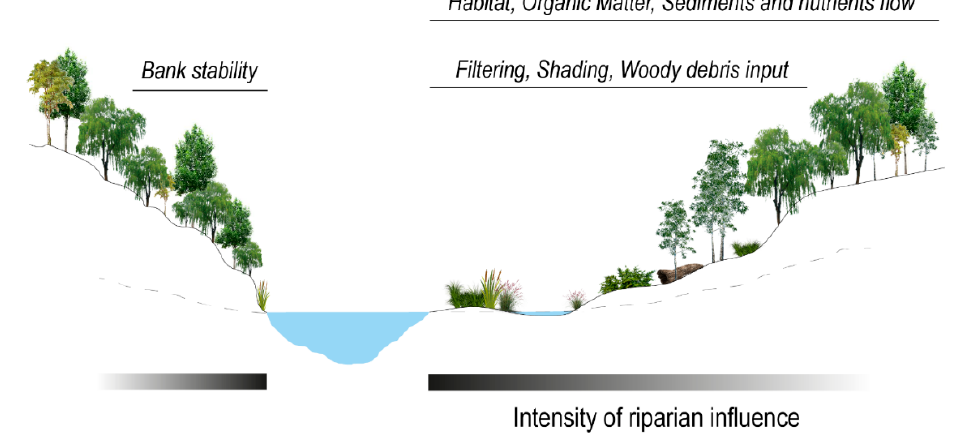
Figure 1. Schematic representation of riparian zones and major ecological functions.